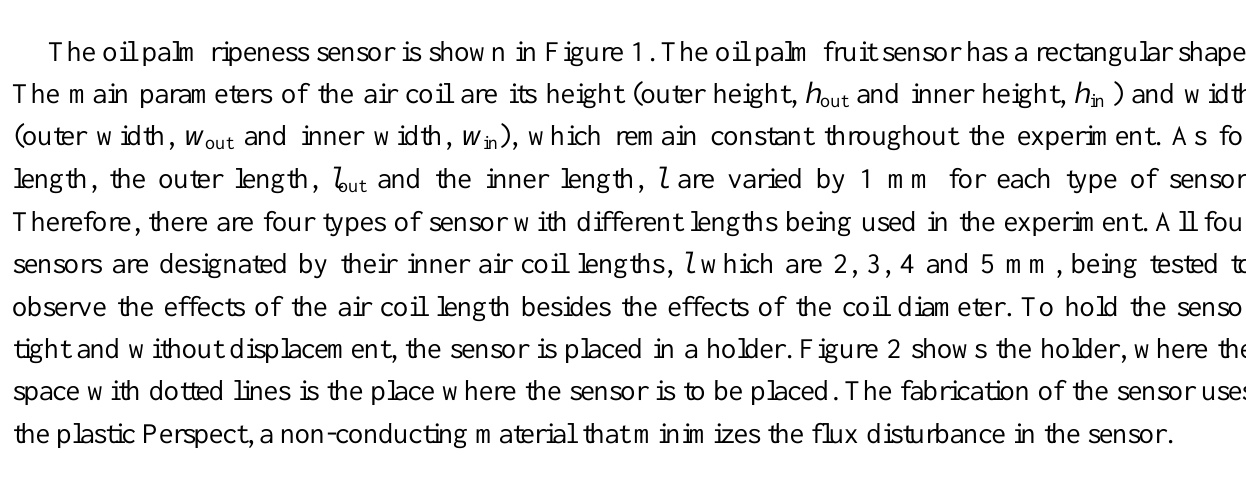
Figure 1. Air coil flat-type shape structure ( a ) top view ( b ) 3D view.